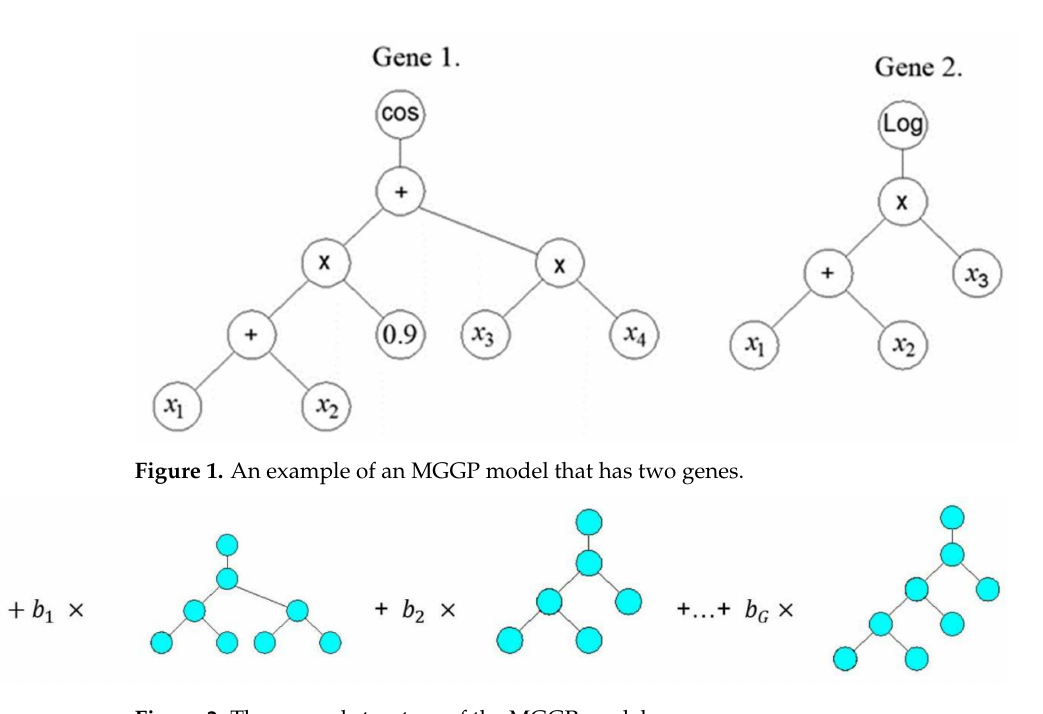
Figure 2. The general structure of the MGGP